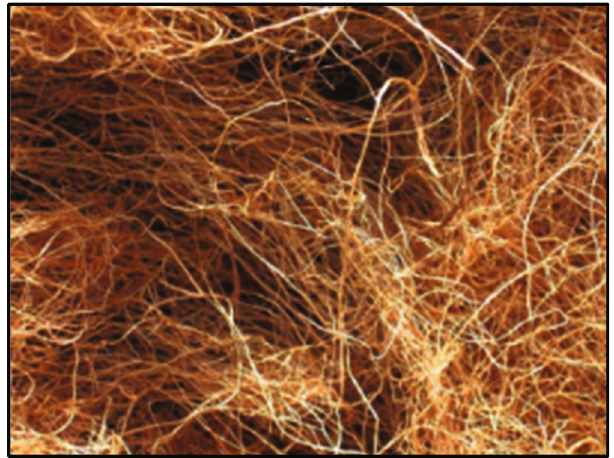
Figure 1: DPF from leaf sheath.